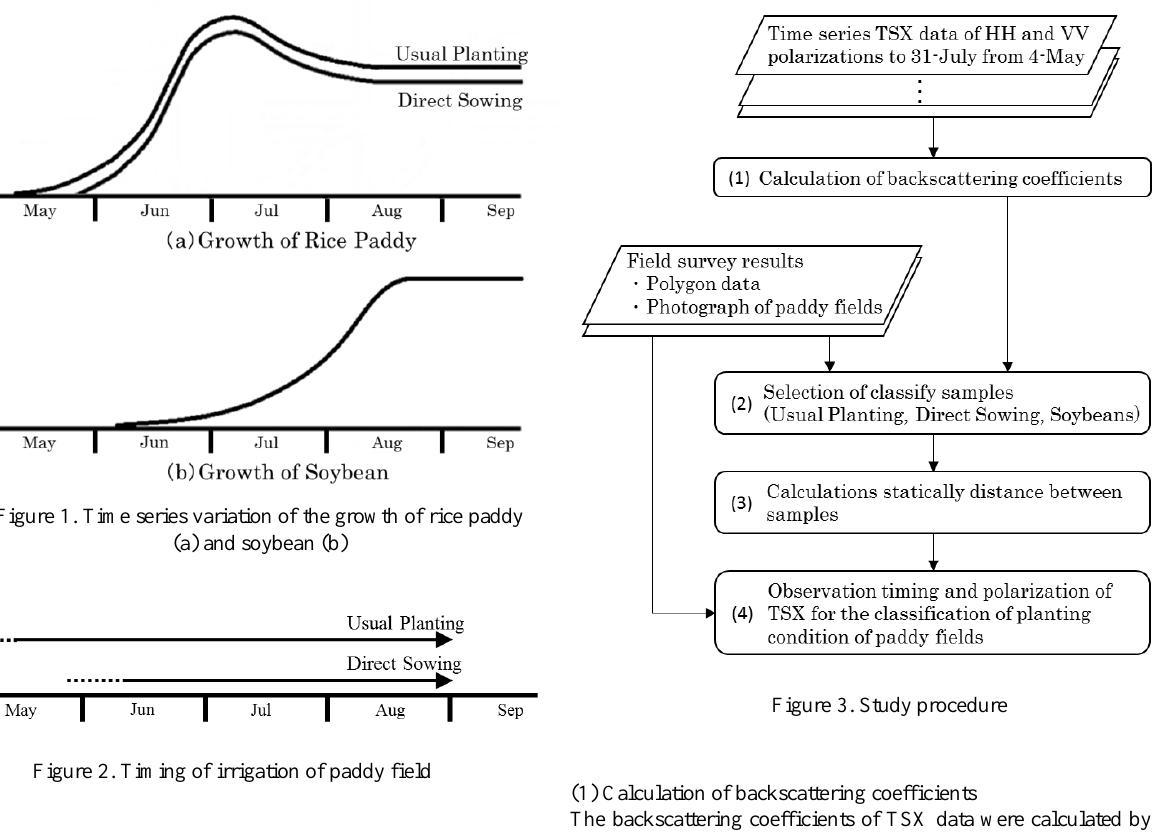
Figure 2. Timing of irrigation of paddy field